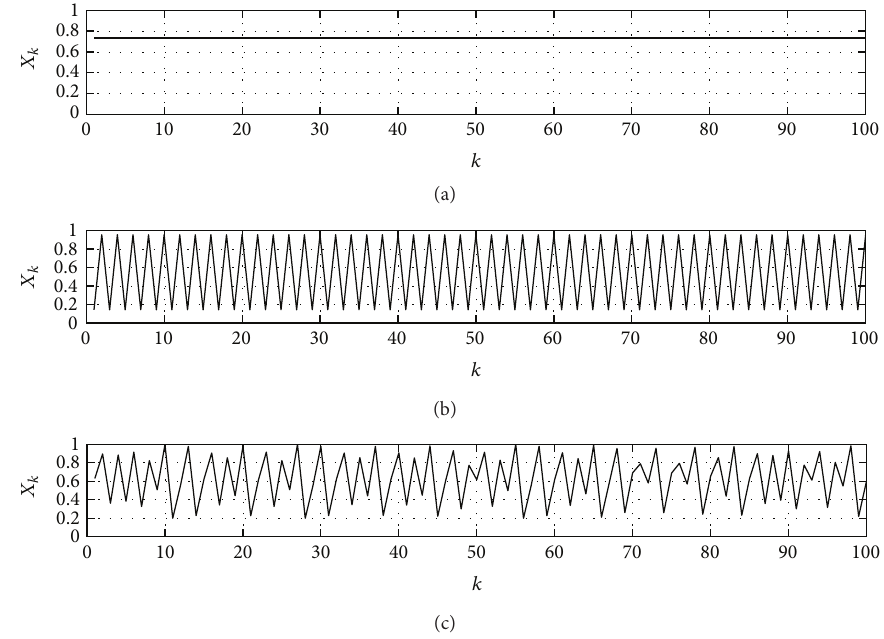
Figure 4: Responses on time: (a) fixed point, (b) periodical oscillation, (c) chaotic oscillation.